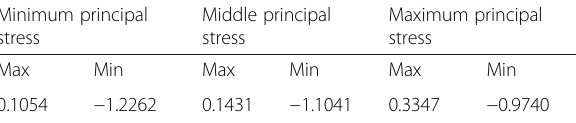
Table 2 Maximum and minimum stress values observed (kPa) Minimum principal stress